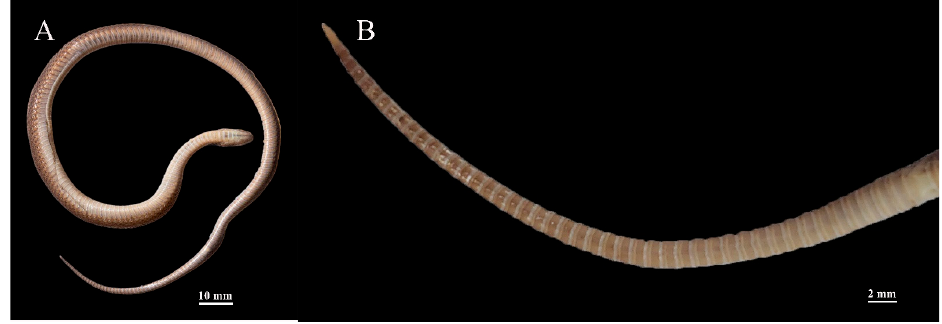
Figure 4. Ventral of the adult female holotype (AHU 2018-EE-0710). ( A ) ventral; ( B ) close-up of cau- dal ventral (showing absence of a dark streak in the middle of caudal ventral). Achalinus dabieshanensis sp. nov. can be differentiated from A. ater by having fewer ventral scales (141–155 vs. 160–170); from A. dehuaensis by having two anterior temporals (vs. only one), fewer subcaudals (45–55 vs. 63–81); from A. emilyae by having fewer sub- caudals (45–55 vs. 60–65) and fewer ventral scales (141–155 vs. 157–166); from A. for- mosanus by having fewer DSR (23//23//23 vs. 27–29//25–27//25), fewer subcaudals (45–55 vs. 61–83), and fewer ventral scales (141–155 vs. 158–169); from A. hainanus by having two anterior temporals (vs. only one), fewer subcaudals (45–55 vs. 67–69), fewer ventral scales (141–155 vs. 165–168), and a relatively short tail (TaL/TL 16.8–22.3% vs. 26–27%); from A. jinggangensis by having the loreal not being fused with the prefrontal (vs. loreal fused with the prefrontal) and fewer ventral scales (141–155 vs. 156–164); from A. juliani by having fewer subcaudals (45–55 vs. 77–91) and fewer ventral scales (141–155 vs. 163–179); from A. meiguensis by having internasals (vs. lacking internasals), lacking postocular (vs. having postocular), and more DSR both anteriorly and posteriorly (23 vs. 21 or 23 and 23 vs. 19, respectively); from A. niger by having fewer ventral scales (141–155 vs. 169–185), fewer DSR anteriorly (23 vs. 25), and fewer middle temporals (23 vs. 25); from A. ningshanensis by having a relatively long tail (TaL/TL 16.8–22.3% vs. 12-16%) and fewer ventral scales (141–155 vs. 171); from A. pangzhihuaensi by having internasals (vs. lacking internasals), lacking postocular (vs. having postocular), and more DSR posteriorly (23 vs. 19), fewer ventral scales (141–155 vs. 160), a relatively short tail (TaL/TL 16.8–22.3% vs. 24.6%), and fewer subcaudals (45–55 vs. 73); from A. pingbianensis by having fewer supralabials (six vs. seven), fewer subcaudals (45–55 vs. 56), and fewer ventral scales (141–155 vs. 160); from A. spinalis by having two anterior temporals in contact with eye (vs. upper anterior anterior broadly in contact with eye) and fewer infralabials (five vs. six); from A. tranga- nensis by having fewer DSR anteriorly (23 vs. 25), a relatively short tail (TaL/TL 16.8–22.3% vs. 25%), fewer subcaudals (45–55 vs. 73+), and fewer ventral scales (141–155 vs. 171); from A. werner by having a relatively short tail (TaL/TL 16.8–22.3% vs. 25%), fewer subcaudals (45–55 vs. 67–98), and fewer ventral scales (141–155 vs. 157–191); from A. yangdatongi by having more DSR posteriorly (23 vs. 19), fewer vetral scales (141–155 vs. 161), a relatively short tail (TaL/TL 16.8–22.3% vs. 26.2%), and fewer subcaudals (45–55 vs. 82); and from A. zugorum by having fewer infralabials (five vs. seven), fewer DSR anteriorly (23 vs. 25), fewer subcaudals (45–55 vs. 70), and fewer ventral scales (141–155 vs. 173). Comparisons between the new species and its congeners are summarized in Table 4.